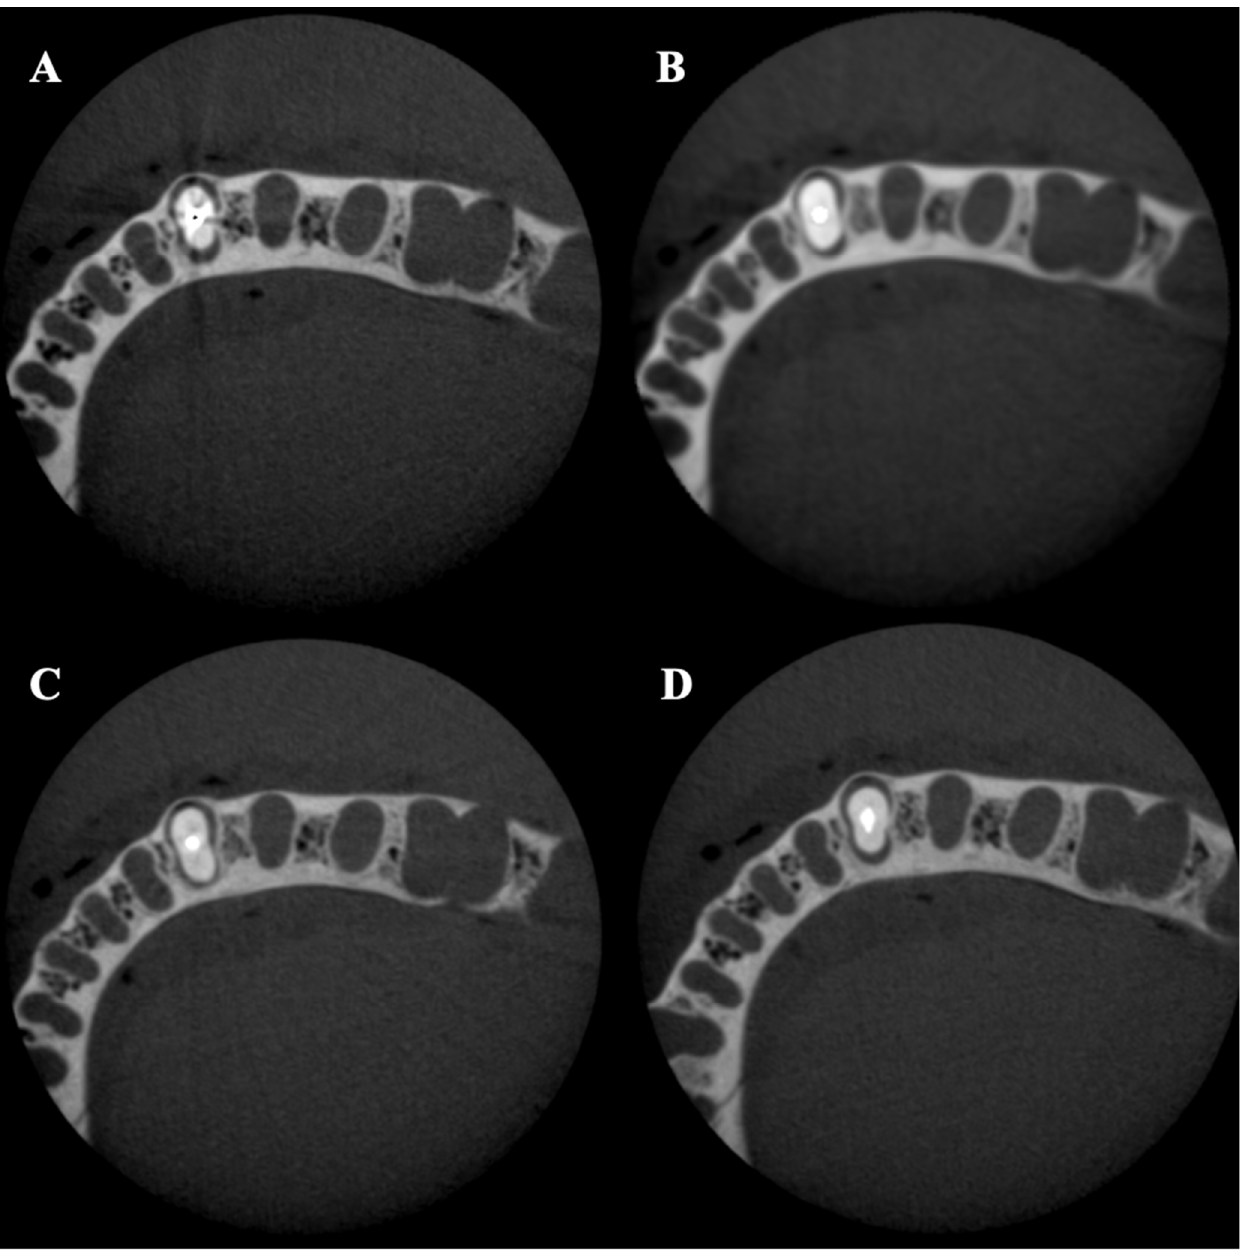
Figure 2. Axial slices of middle thirds for each post material obtained with no MAR, 90 kVp, and 100 voxels: ( A ) gold-plated post; ( B ) titanium alloy post; ( C ) quartz fiber (Bisco DT Light) post; ( D ) glass Fiber (Rely X) post.